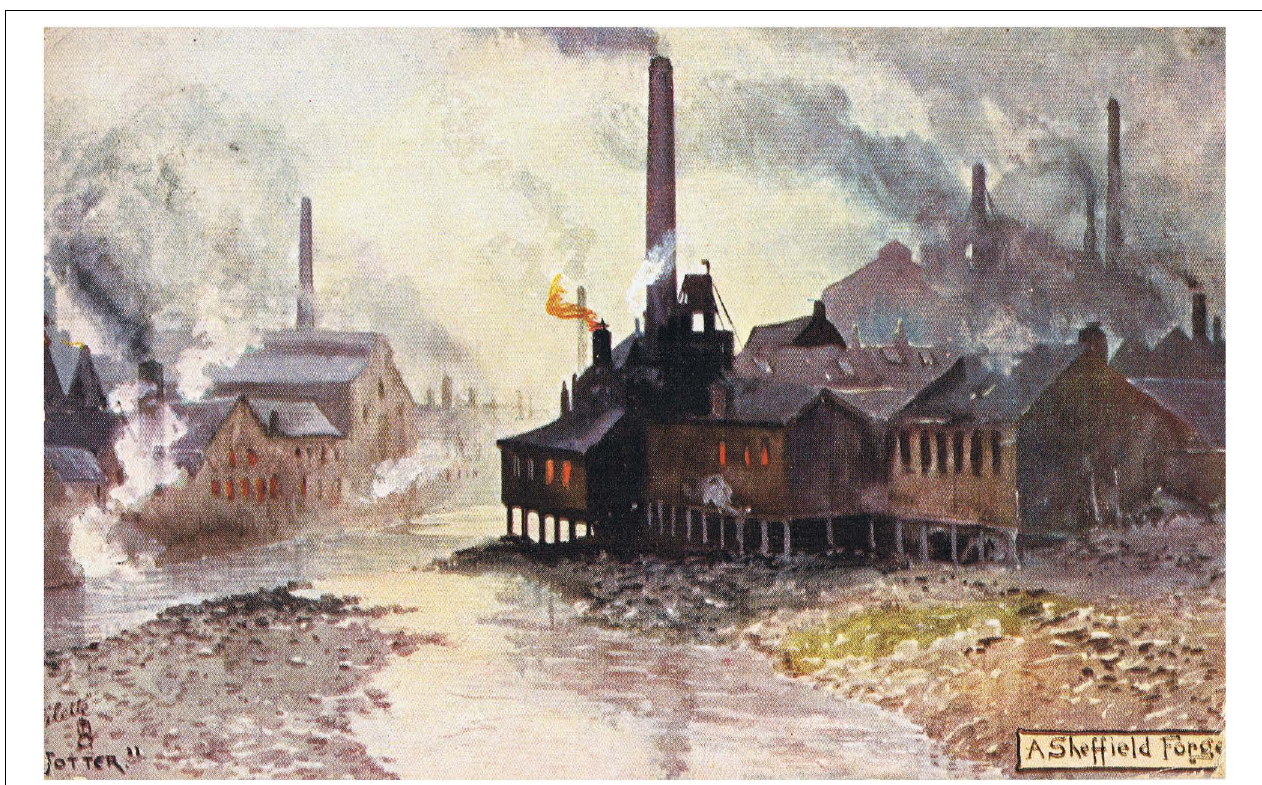
FIGURE 5 | A Sheffield forge on the River Don,